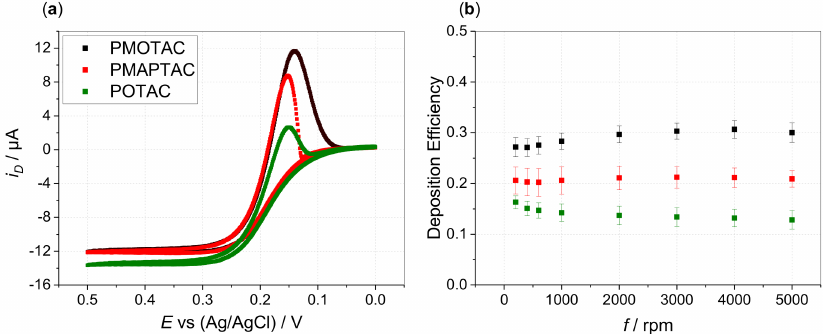
Figure 4. ( a ) Disk currents in hydrodynamic voltammograms at 5000 rpm (disk potential scanned from 0 to 0.5 V (forward scan) and back to 0 V (backward scan) vs. Ag/AgCl with ν = 5 mV/s) and ( b ) Deposition efficiency vs. rotation rate f of 0.13 mM HCF(II) in 0.1 M KCl in presence of 0.52 mM PMOTAC (black), PMAPTAC (red), POTAC (green) (with respect to quaternized units, icr = 1). DE values are averaged over six measurements of freshly prepared solutions (error bars show the standard deviation of the shown mean